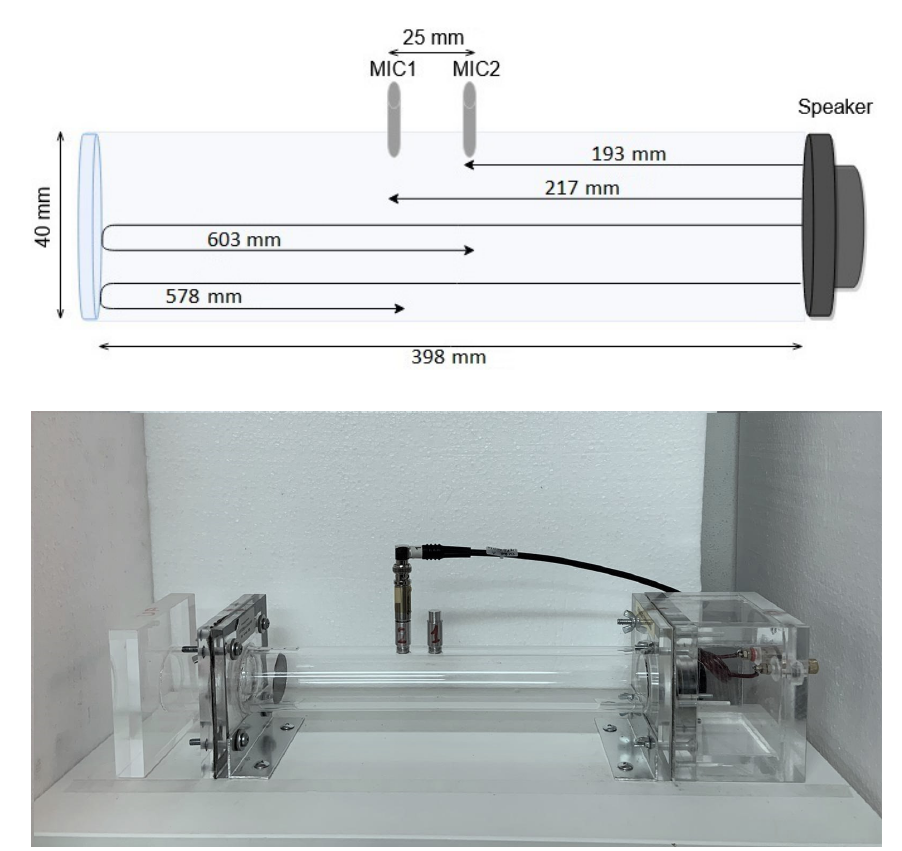
Figure 7. Effective dimensions ( top ) and actual photograph ( bottom ) of the impedance tube used in the ISO 10534-2 measurements. Table 2. Equipment used for the impedance tube